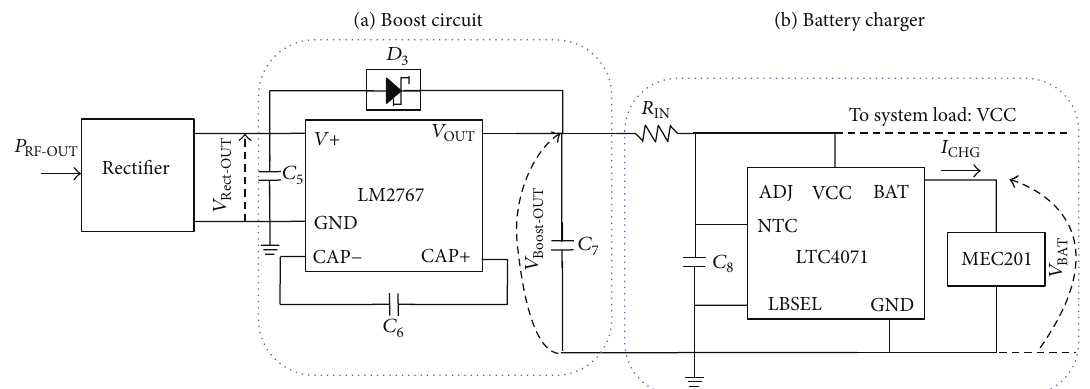
Figure 9: Schematic representation of the power management unit (see Figure 1(a)). In particular, the external lumped elements and the pins connection used for implementing the boost circuit (a) and the battery charger (b) are illustrated.